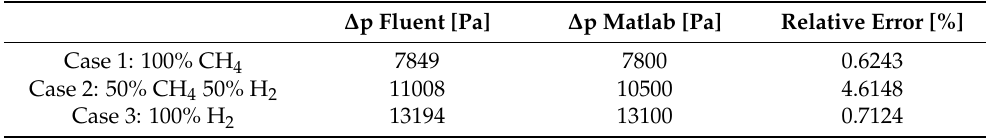
Table 5. Comparison of pressure drop according to 2D CFD in ANSYS Fluent and the MATLAB